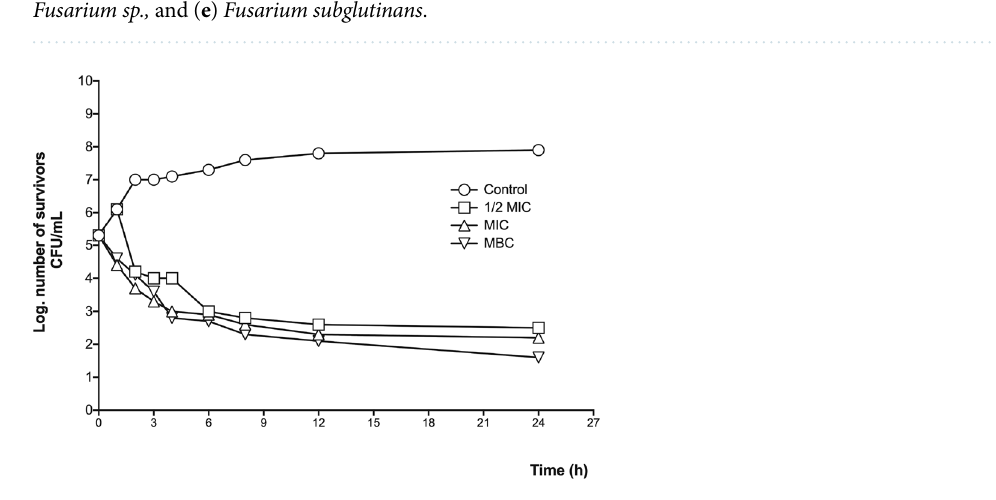
Figure 3. Time-killing bacterial kinetic assay of the methanolic leaf extract against S. aureus ATCC 12,398. 1/2 MIC = 0.31 mg/mL; MIC = 0.62 mg/mL; MBC = 1.25